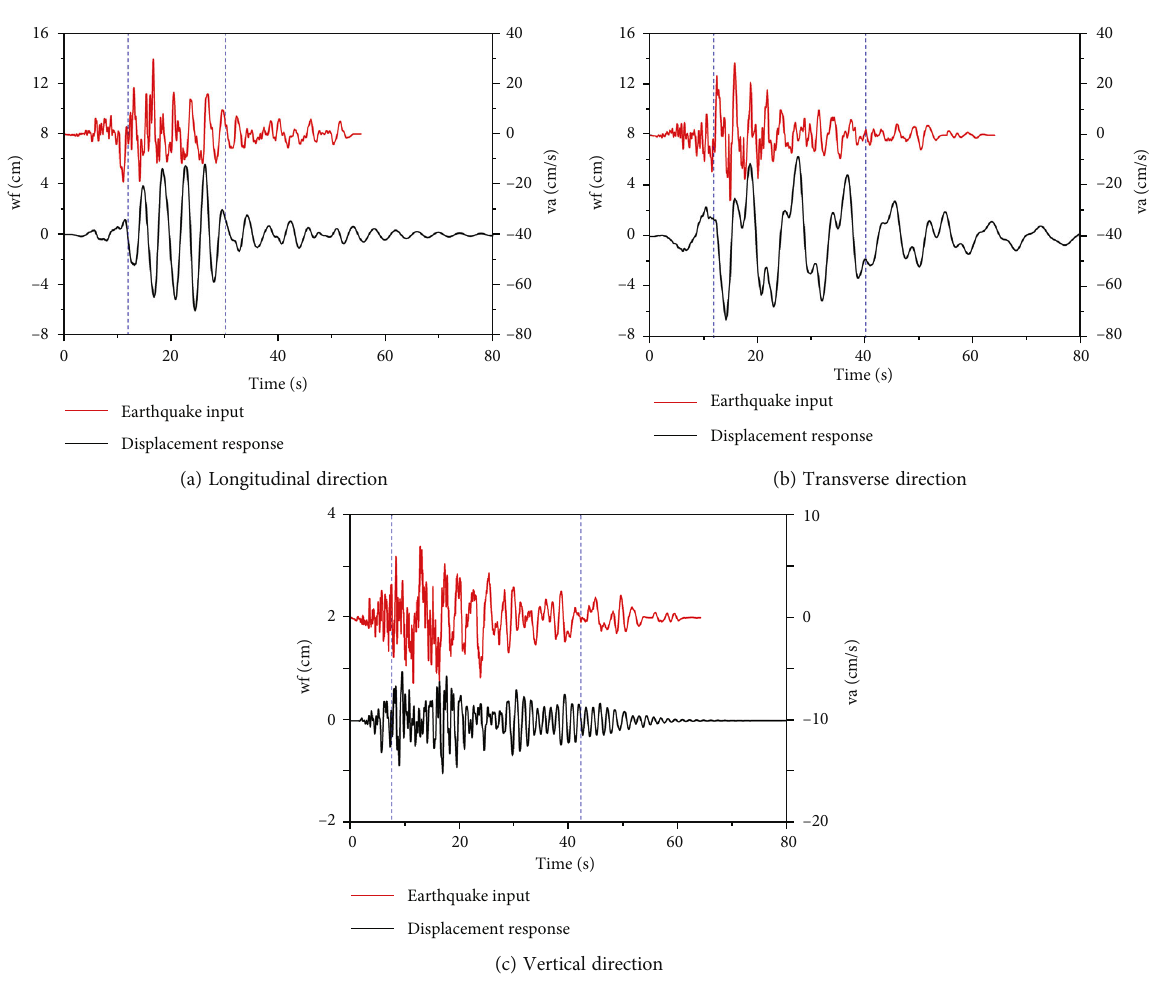
Figure 5: Displacement at the top of the arch during non-near-fault ground motion with